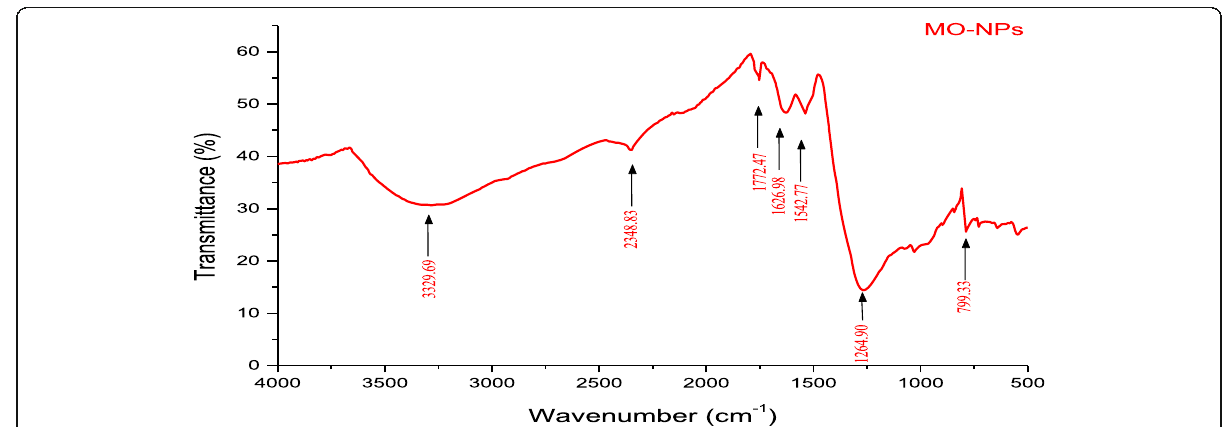
Fig. 1 Fourier transform infrared spectroscopy (FTIR) spectra of silver nanoparticles synthesized from M. oleifera leaf